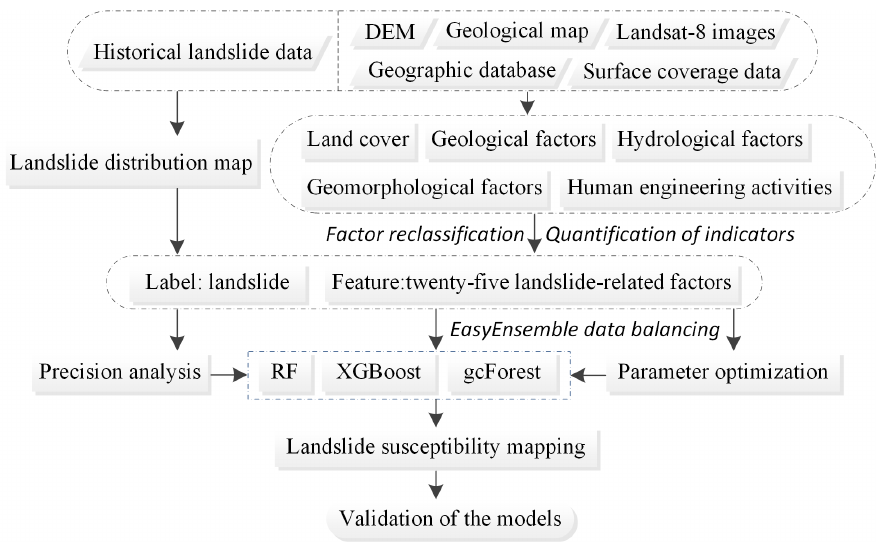
Figure 1. Flowchart of this study